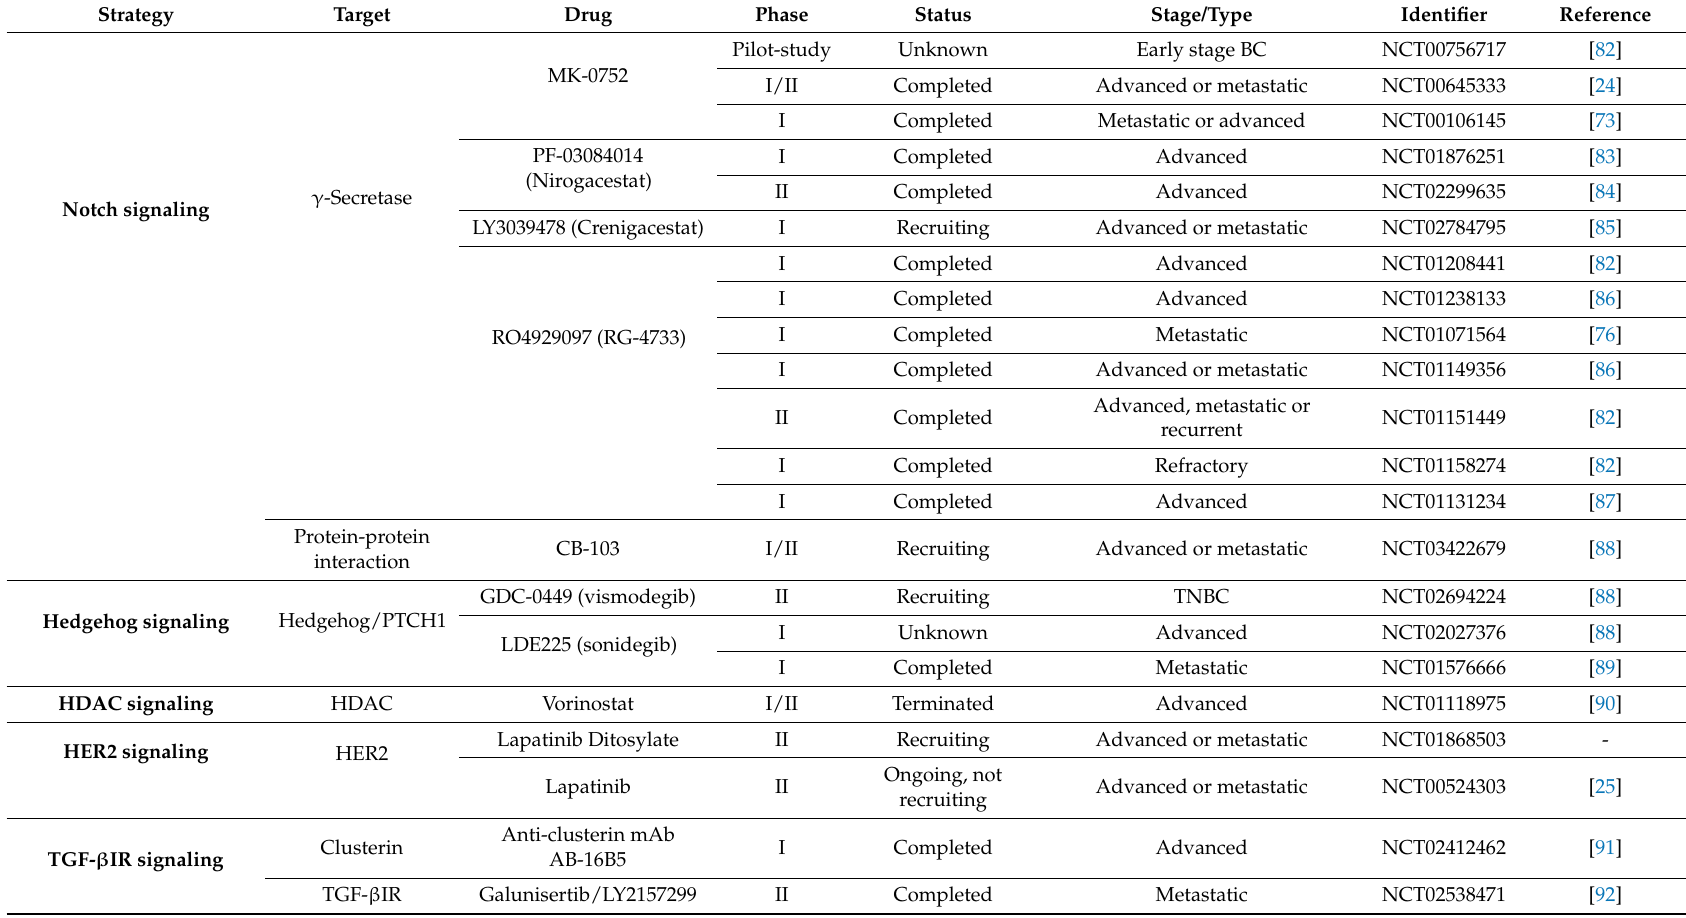
Table 2. List of BCSC-targeted strategies used in clinical